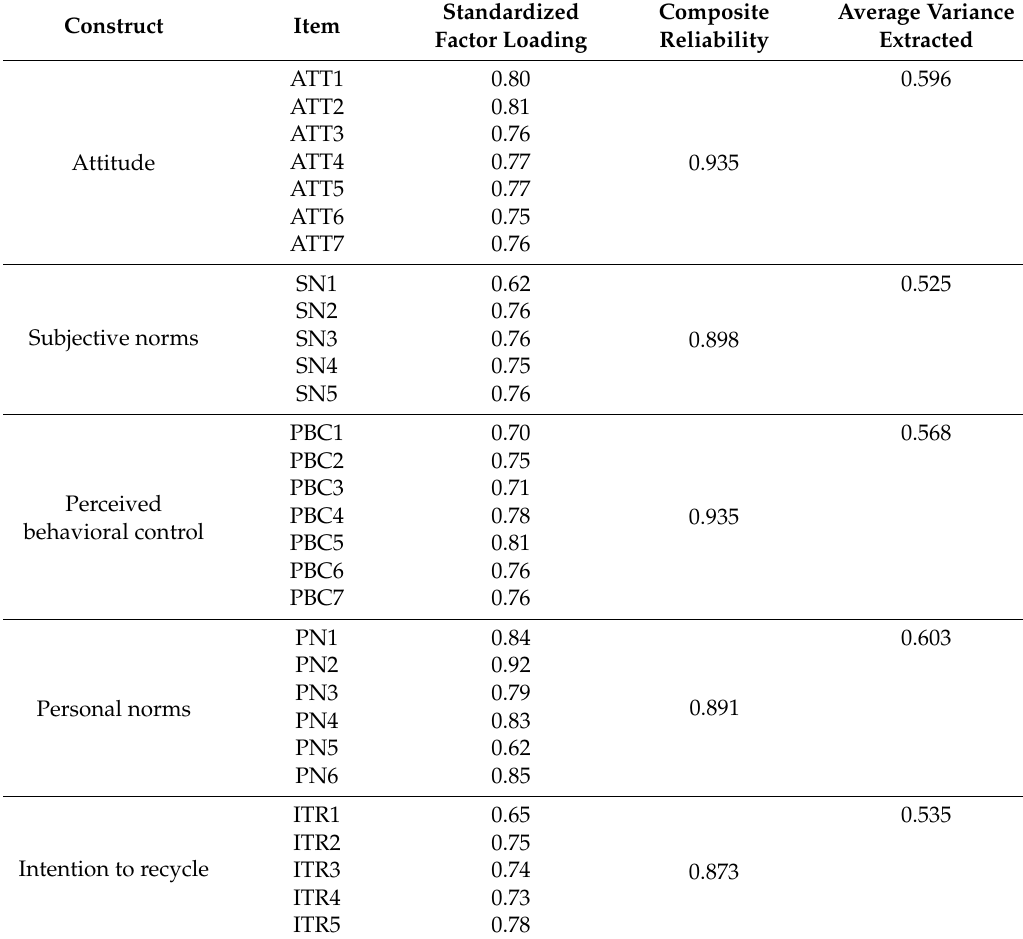
Table 3. Reliability and Convergent Validity of the Measurement